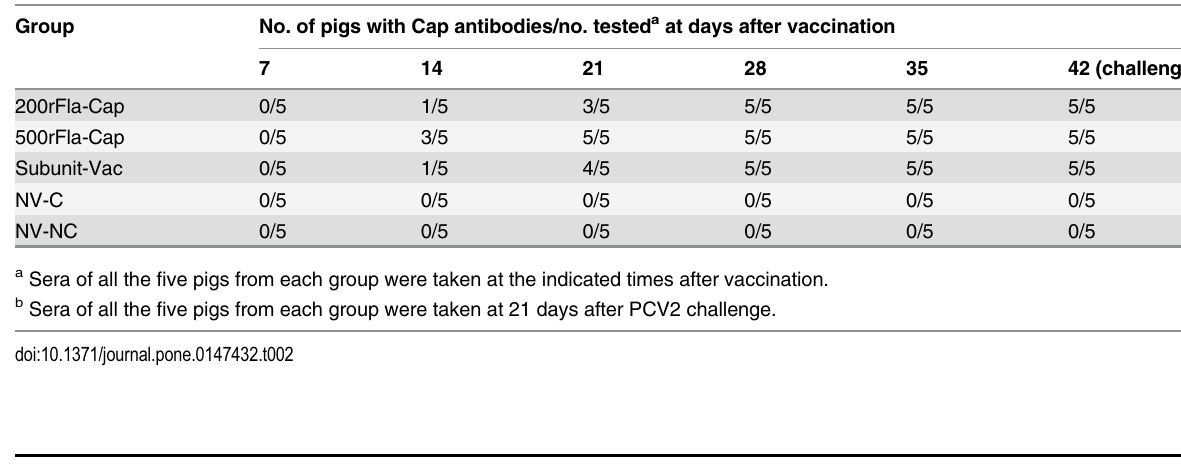
Table 2. Seroconversion to PCV2 Cap-specific antibodies in pigs vaccinated with rFla-Cap proteins. Group